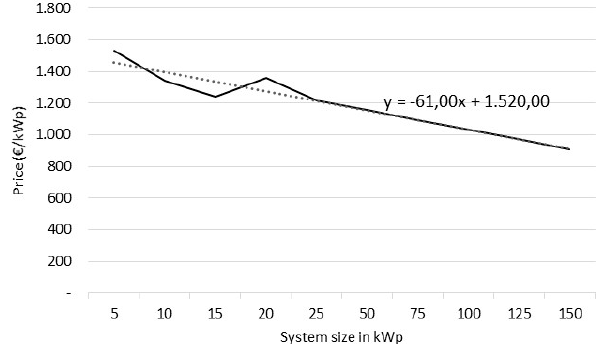
Figure 2. Price curve (with trend line) of photovoltaic (PV) systems according to sizing.